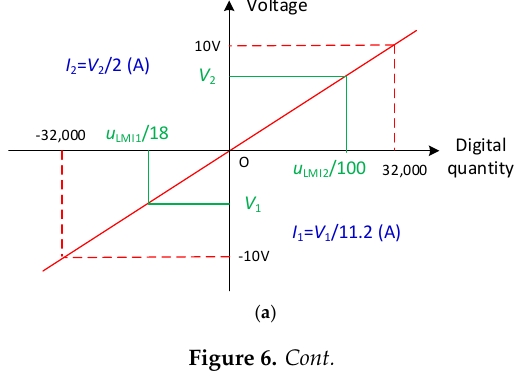
Figure 5. The experimental platform based on HTS: ( a ) view of configurations elements of experimental platform; ( b ) online real-time control based on Siemens S7-200 controller system and workflow of Kingview communication. ( a )